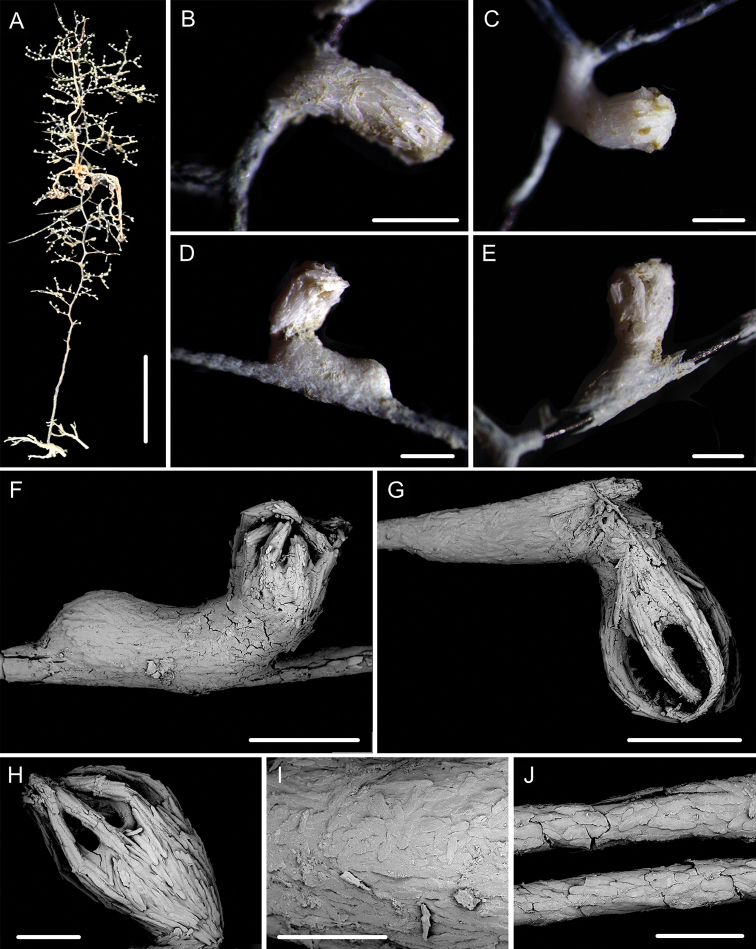
External morphology and polyps of Pseudochrysogorgia
bellonaA the colony after collection B–E a single polyp under a light microscope F, G a single polyp under SEMH head of one polyp under SEMI basal polyp body under SEMJ coenenchyme under SEM. Scale bars: 10 cm (A), 1 mm (B–G), and 500 μm (H–J).